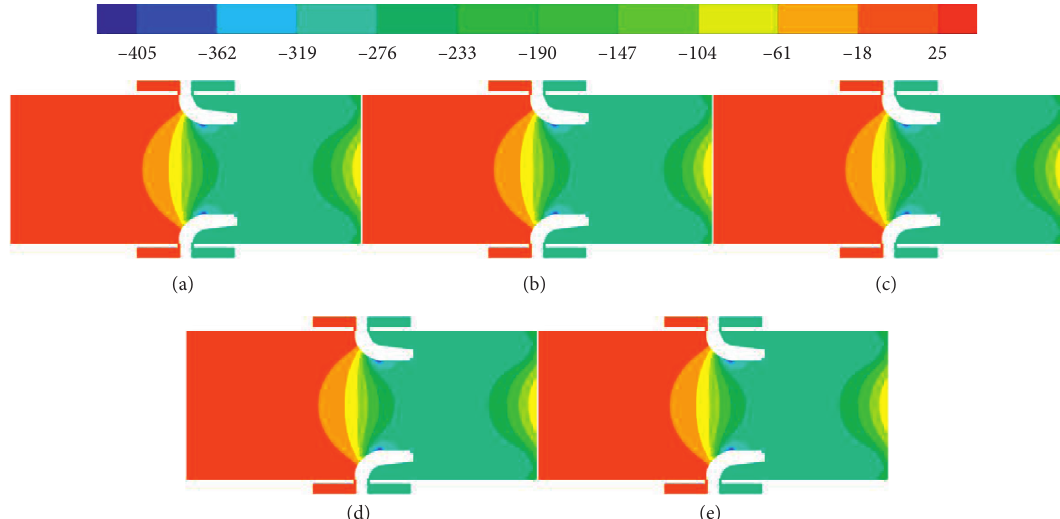
Figure 14: Pressure field distribution of cross section in flow meter (1000m 3 /h). (a) 50 ° C. (b) 100 ° C. (c) 300 ° C. (d) 500 ° C. (e) 700 °